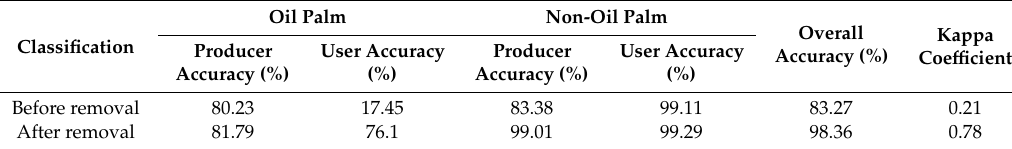
Table 6. Producer, User and Overall classification accuracies for oil palm and non-oil palm classes before and after removal of the misclassified